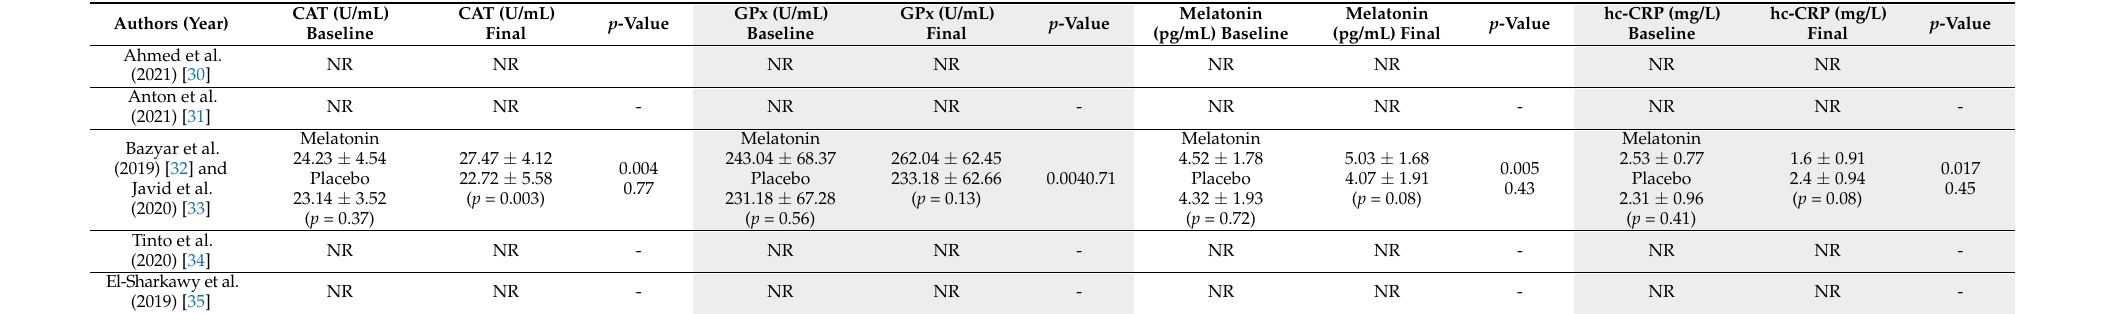
Table 6. Biochemical parameters found in the included studies (Part